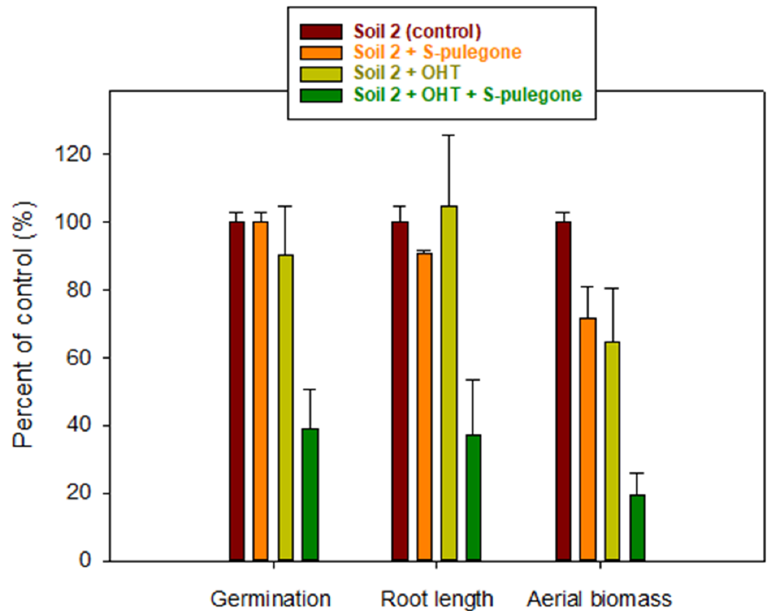
Figure 6. Effect of S ‐ pulegone applied at 12 kg/ha on germination, root length, and aerial biomass of Lactuca sativa sown in non ‐ covered pots filled with unamended and OHT ‐ amended soil 2. Error bars correspond to the standard errors of triplicate measurements.